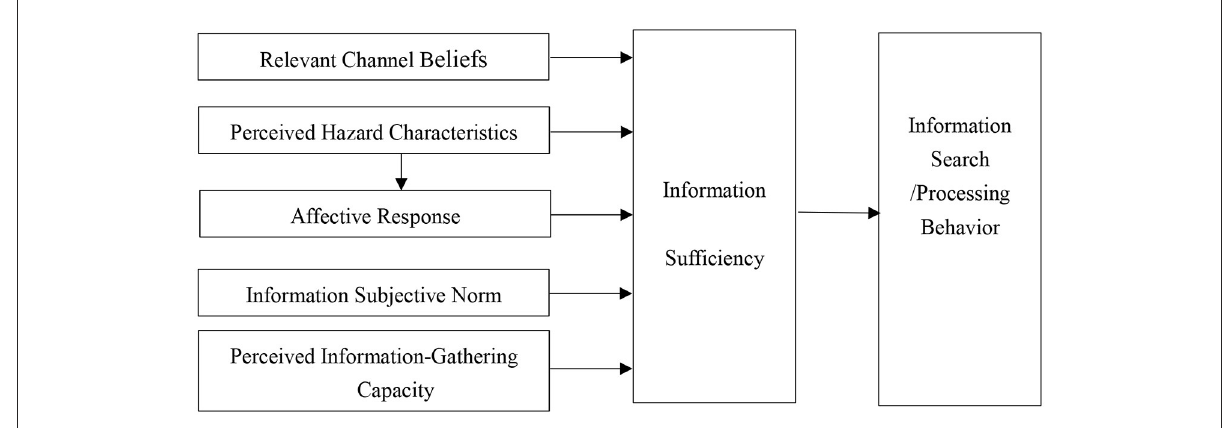
FIGURE1 Risk information search and processing model.